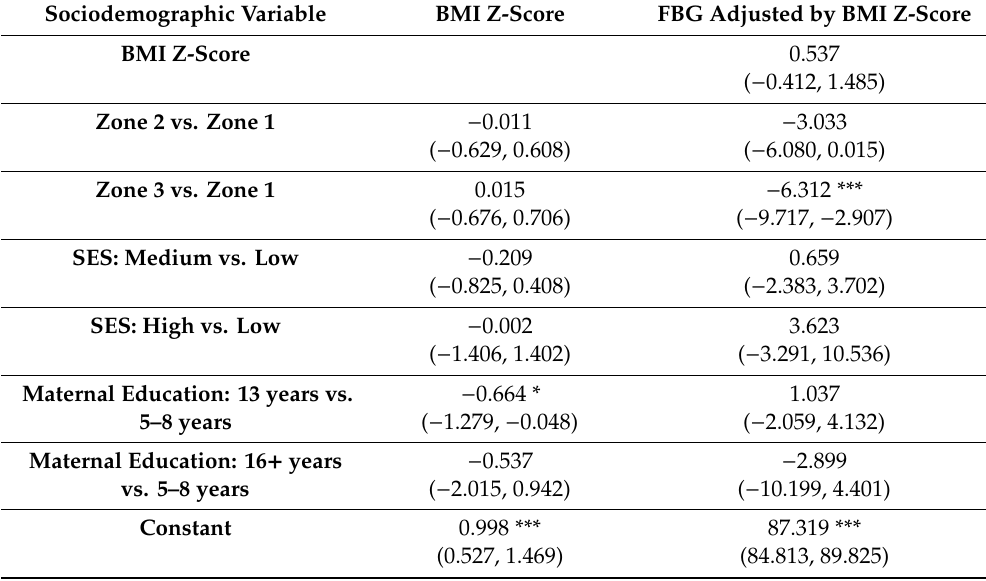
Table 4. Female participants ( n = 114): Linear regression coe ffi cients and 95% confidence intervals for associations of (i) residential zone; (ii) socio-economic status (SES) index; and (iii) maternal education level to body mass index (BMI) Z-score and BMI-adjusted fasting blood glucose (FBG).